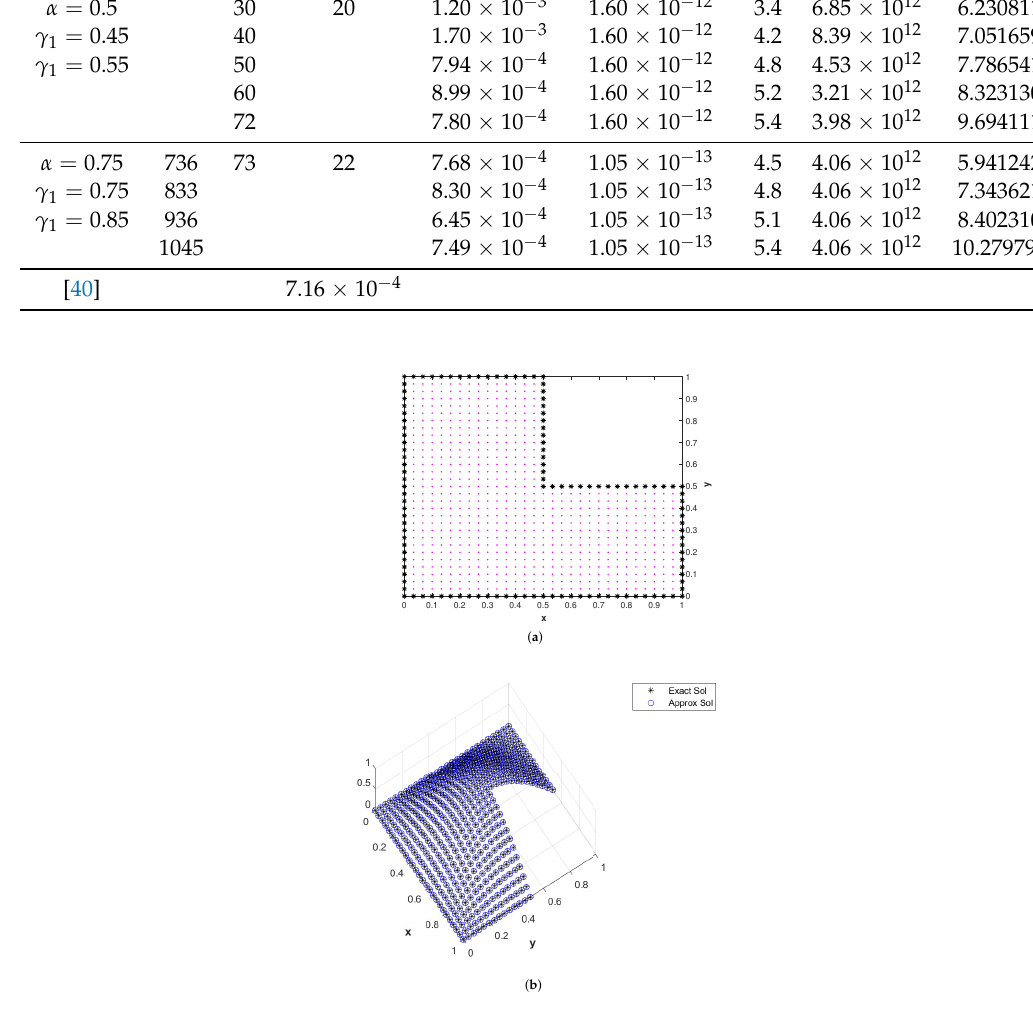
Figure4. ( a )NodesintheL-shapeddomain;( b )theexactandnumericalsolutionsintheL-shaped domain. Figure 4. ( a ) Nodes in the L-shaped domain; ( b ) the exact and numerical solutions in the L-shaped